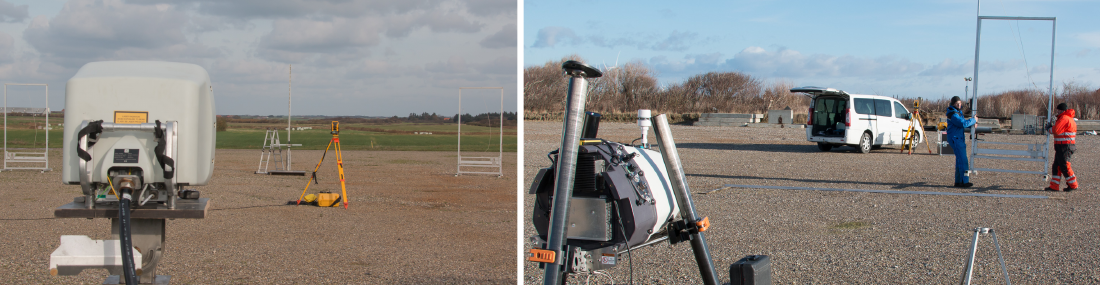
Figure 4. Field testing of the 5B ( left ) and ZDM ( right ): inclinometers calibration and beam trajectory